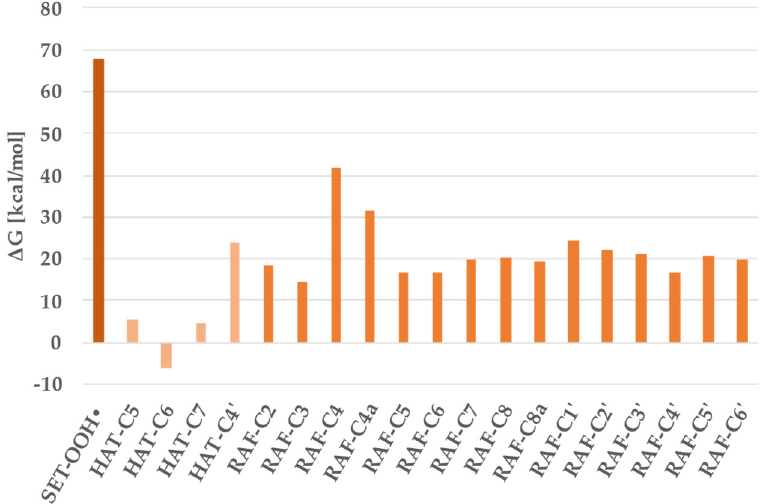
Figure 2. Gibbs reaction free energies of ( ∆ G) at 298.15 K for scutellarein against hydroperoxyl radical in pentyl ethanoate solvent. Table 2. Gibbs free energy of reaction ( ∆ G) and activation ( ∆ G ‡ ) [kcal/mol] at 298.15 K for the HAT mechanisms in a lipid-like environment (the superscript (PE) indicates pentylethanoate solvent). OH